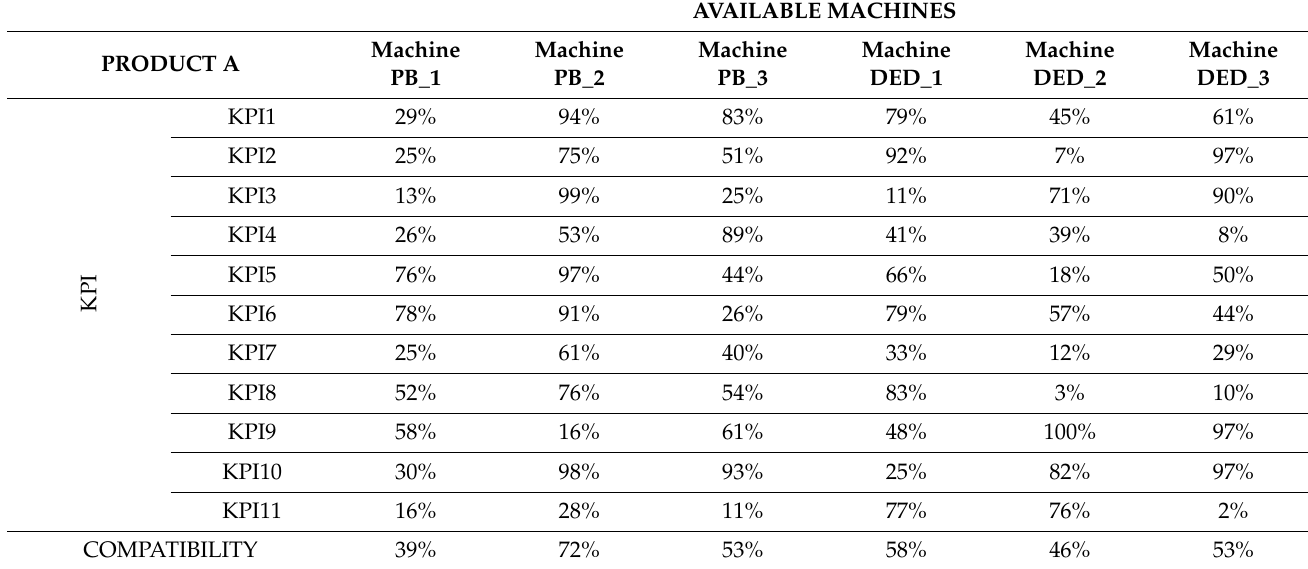
Table 1. Matrix example that associates the Key Performance Indicator (KPIs) with the various machine types available on the platform (Powder Bed, PB or Directed Energy Deposition, DED).